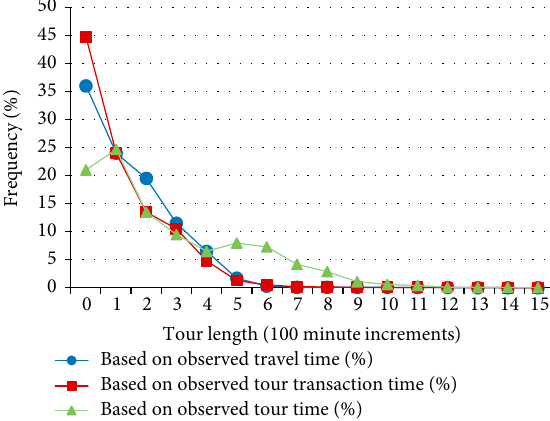
Figure 8: Observed tour length distributions for a